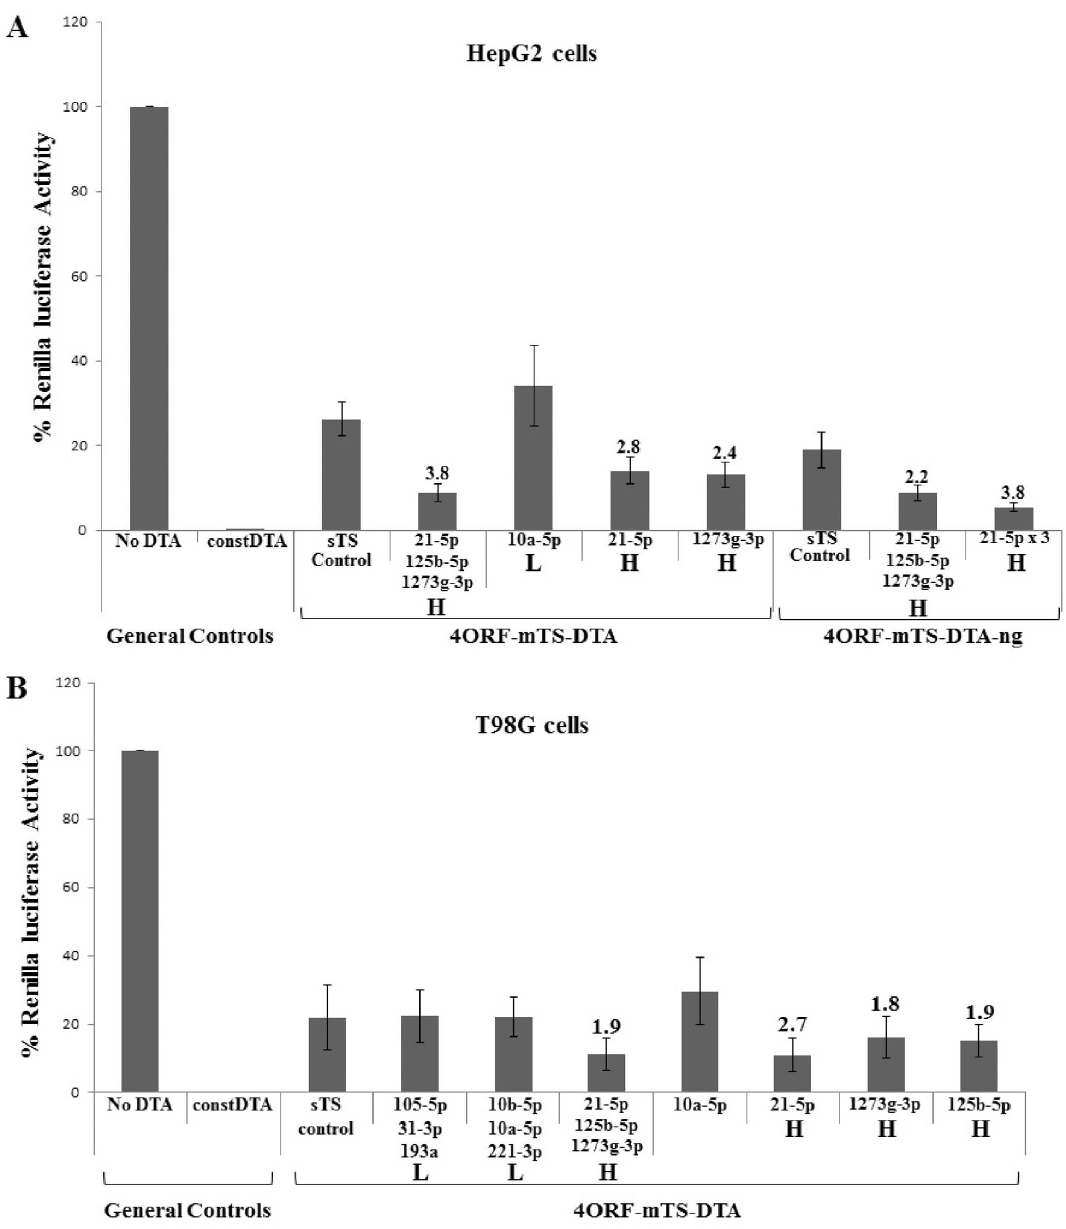
Fig. 7. Induction of DTA by endogenous miRNAs in constructs containing single miRNA target sites. (A) Experiments in HepG2 cells. (B) Experiments in T98G cells. HepG2 cells (8 6 10 4 ) were transfected with the indicated DTA construct (175 ng), a luciferase reporter plasmid (25 ng). T98G cells (5 6 10 4 ) were transfected with the indicated DTA construct (50 ng), a luciferase reporter plasmid (150 ng). The renilla luciferase activity of the ‘‘No DTA’’ construct was set as 100% and the luciferase activity obtained for all other constructs were compared to the No DTA level. The ‘‘Const DTA’’ construct had no UIR, with the DTA transgene directly driven by the CMV promoter. Each bar on the X-axis stands for a construct containing different TS region. The ‘‘sTS’’ control was the 4ORF construct with target sites for siRNAs S4 and S5. The miRNAs for which fully matched target sites were included in the TS are indicated below the bars. The relative level of expression of the miRNAs in the cells (see Table 2) are marked as L (Low), M (Medium) or H (High). The numbers above the bars indicate the fold reduction of luciferase activity (and thus induction of DTA activity) between the relevant construct and the sTS control construct. The experiments described in A and B were repeated 3 times. Each experiment was done in triplicates. Statistical analysis was done by T- test and the bars represent standard error. P values in A for all construct with targets for highly expressed miRNAs (H) were , 0.03. P values in B were significant for the construct with a target site for miR-21-5p (0.03) but not significant ( . 0.08) for the constructs with target sites for other